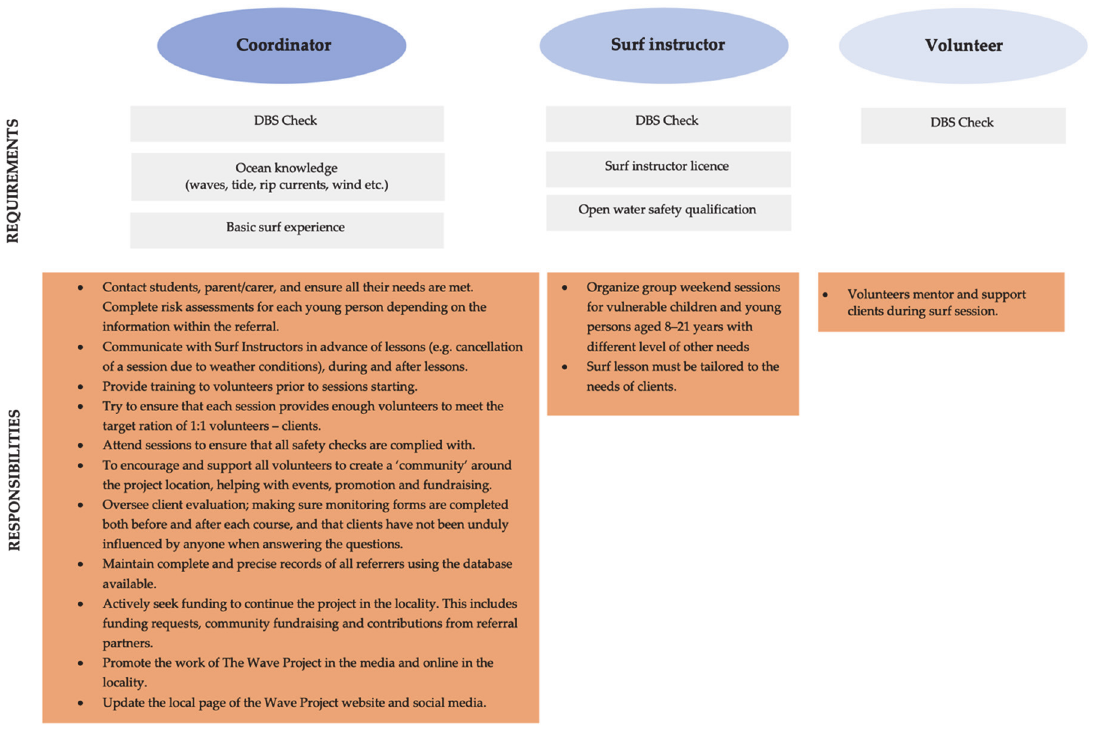
Figure 2. Surf therapy staff—positions directly working with